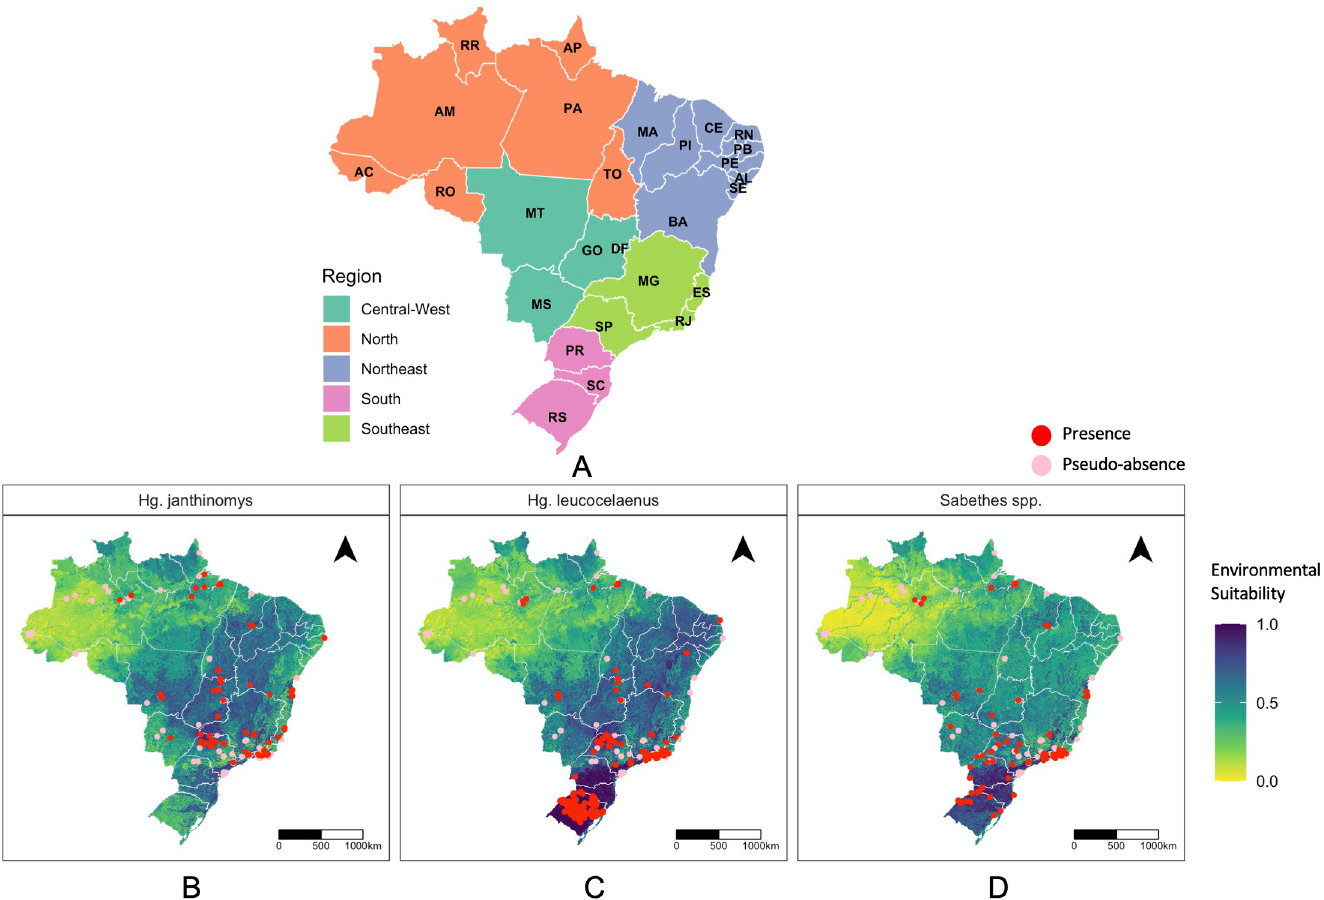
Fig 3. Environmental suitability and occurrence records of Haemagogus and Sabethes spp . A, Map of Brazil by states (AC–Acre, AL–Alagoas, AP–Amapa´, AM– Amazonas, BA–Bahia, CE–Ceara´, DF–Distrito Federal, ES–Espı´rito Santo, GO–Goia´s, MA–Maranh ā o, MT–Mato Grosso, MS–Mato Grosso do Sul, MG–Minas